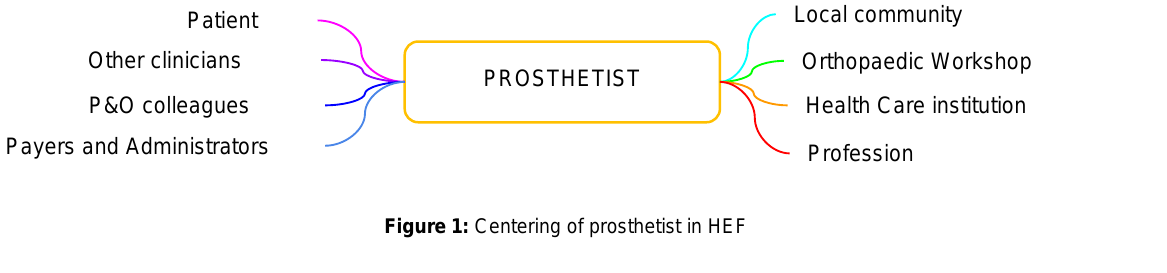
Ratto M. Designing a digital toolchain for prosthetics: A retrospective. Canadian Prosthetics & Orthotics Journal. 2021; Volume 4, Issue 2, No.16. https://doi.org/10.33137/cpoj.v4i2.36188